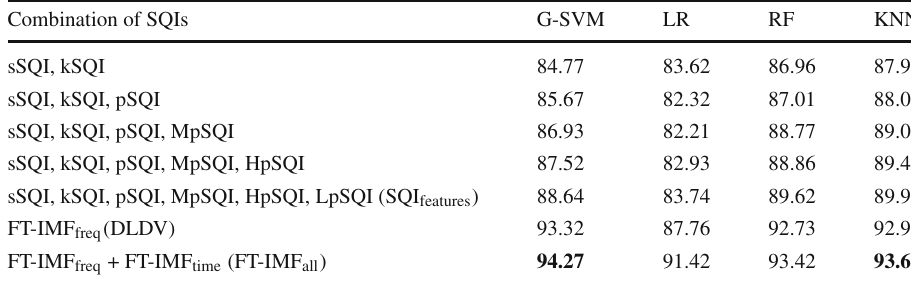
Table 5 Average Acc of fivefold cross-validation performed on balanced set-a using four classifiers for the different combinations of SQIs